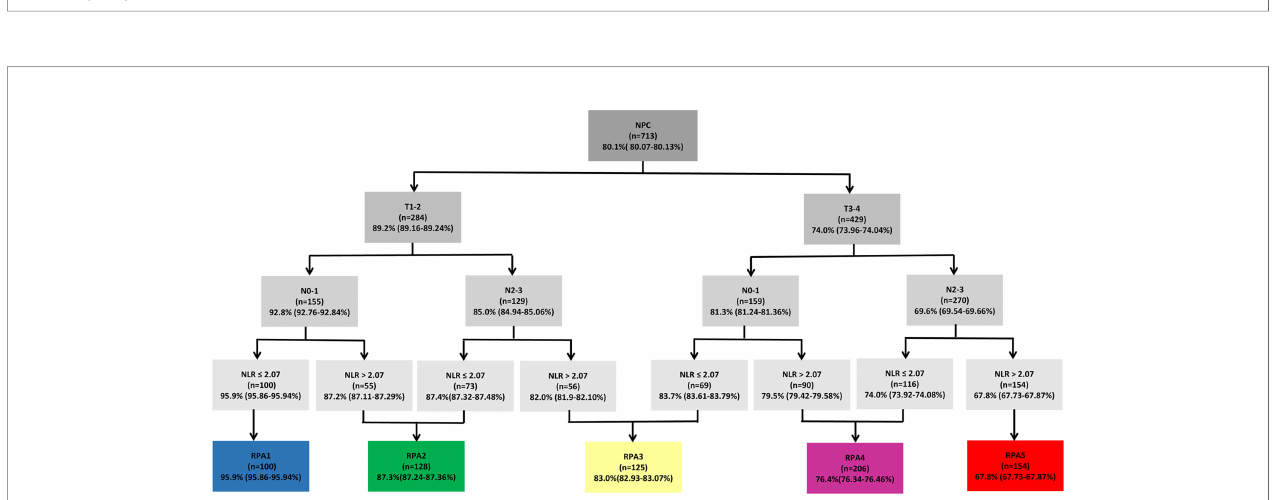
FIGURE 4 | Recursive partitioning analysis for the endpoint of 5-year overall survival of 713 patients, based on the optimized binary partition of T-, N- categories and NLR. RPA, Recursive partitioning analysis; NLR, Neutrophil-to-lymphocyte